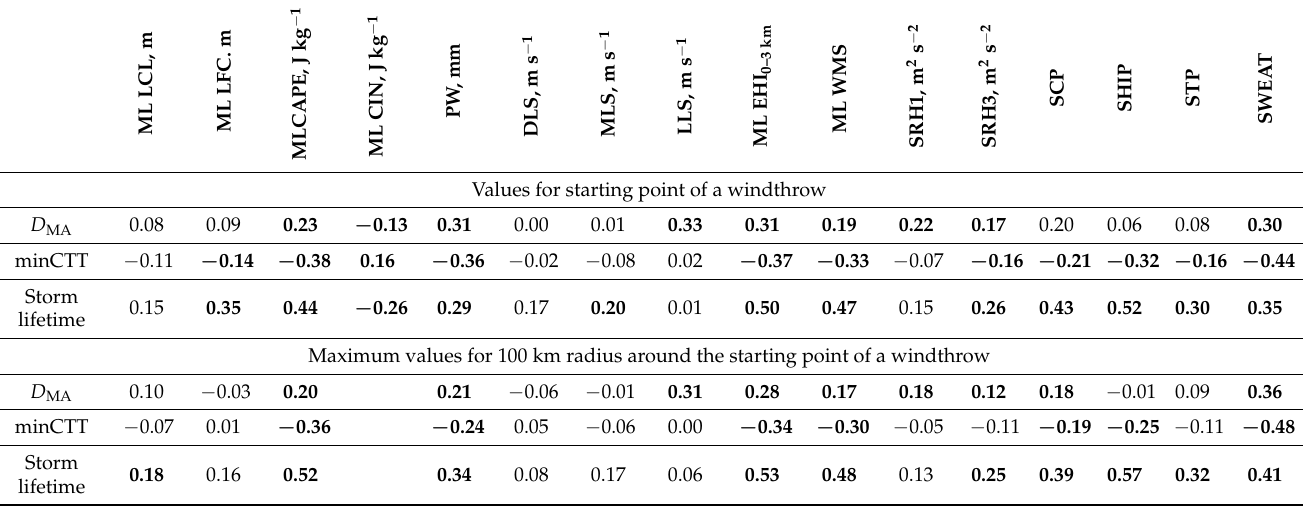
100-km buffer (Table 1). For convective storms that caused more than one tornado or linear windstorm, we used the averaged values of convective indices for these events. Table 1. The Spearman rank correlation coefficients between the characteristics of convective storms and the values of environmental variables. Statistically significant (at the 0.05 level) correlations are shown in bold font.